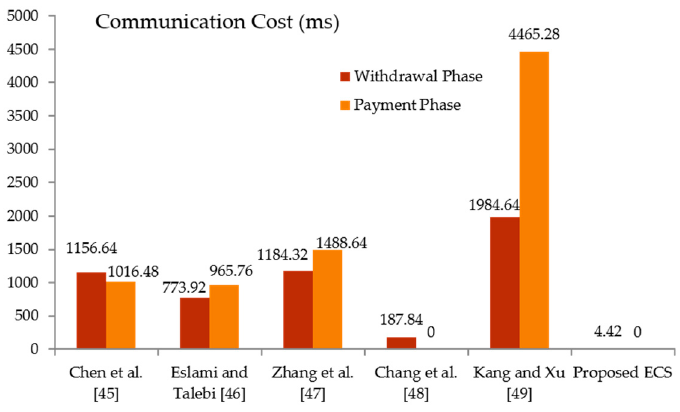
Figure 3. Communication cost (ms) in withdrawal and payment phases.